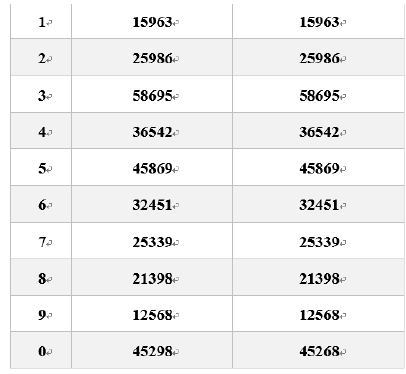
Figure 1. Schematic diagram of the numeral inspection task (NIT).